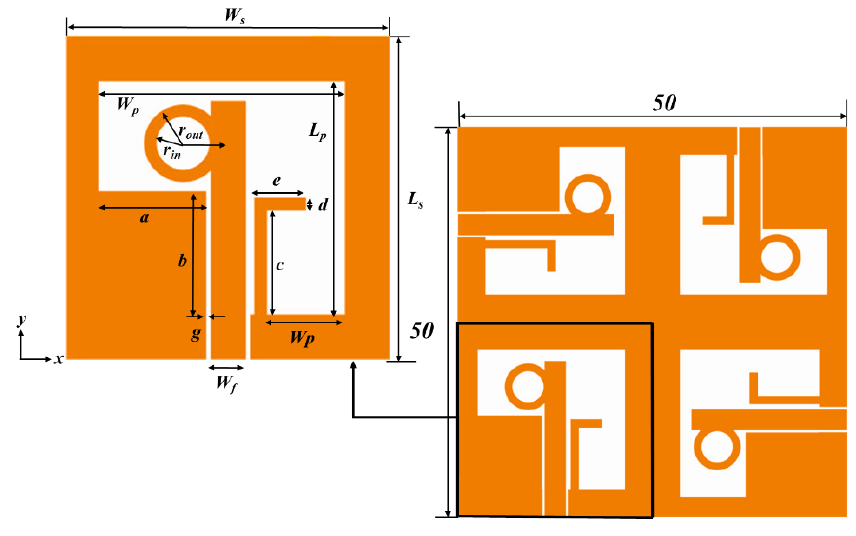
Figure 4. Four-port antenna design. Table 3. Geometrical parameters of the proposed antenna.